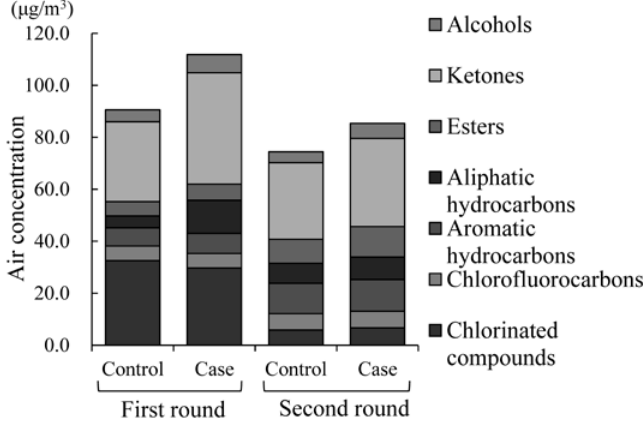
Figure 3. Air concentrations of volatile organic compounds (VOCs).